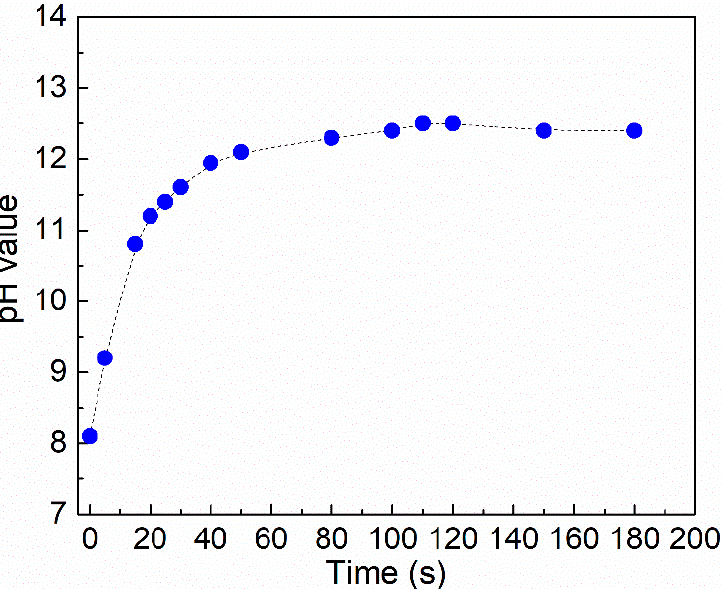
Figure 4. Evolution of pH of SA/cyclen solution (300 mM) with increasing N 2 bubbling time. (Temperature, 25 °C; flow rate of N 2 , 0.1 L·min − 1 ).